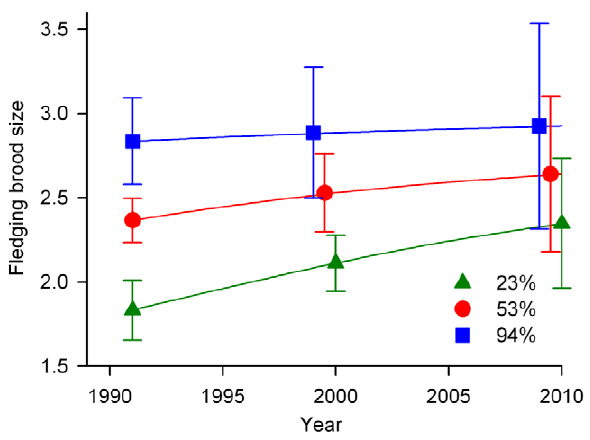
Figure 4. Temporal trends in fledging brood size. Model-based predictions of fledging brood size at 5%, median, and 95% observed values of forest cover (23%, 53%, and 94%, respectively) across a balanced population of three songbird species in Missouri, USA, 1991– 2010. Estimates are for a population at observed frequencies of nests in three habitat types (forest, clearcut, non-forest), with parasitism rates varying across years and forest cover levels on the basis of the parasitism rate model-selection analysis. Error bars represent 95% confidence intervals and are offset for visual clarity.